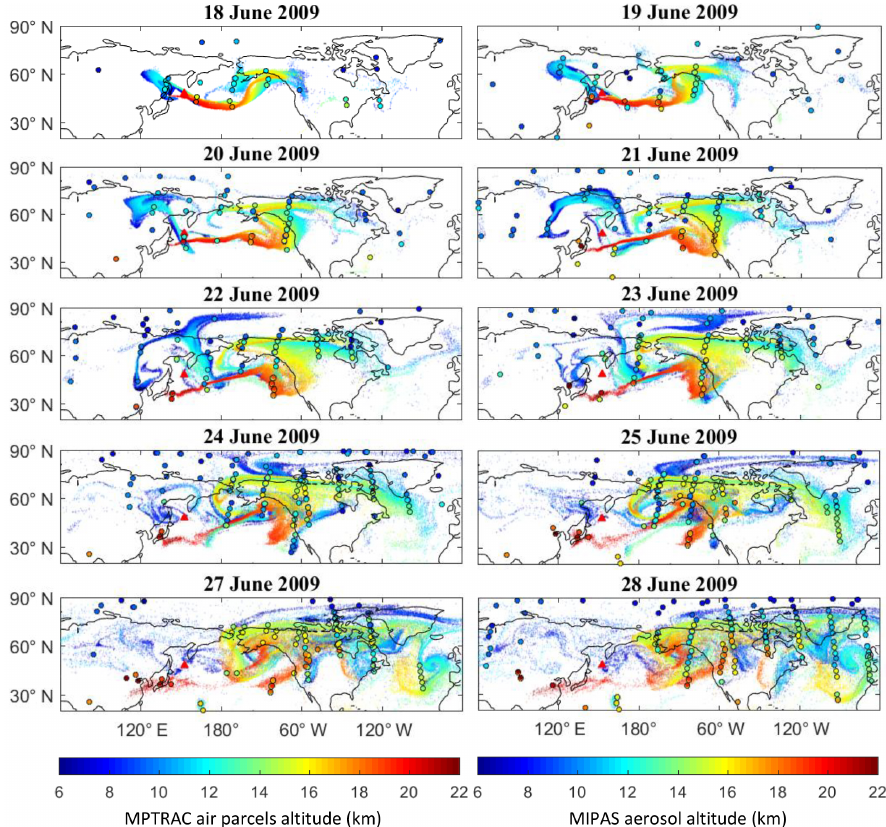
Figure 4. The evolution of SO 2 air parcel altitudes (shading) from MPTRAC simulations (shown for 00:00UTC on selected days) and MIPAS aerosol detections within ± 6h (color-filled circles). The altitudes of all air parcels, regardless of their SO 2 values, are shown. The red triangle denotes the location of the Sarychev